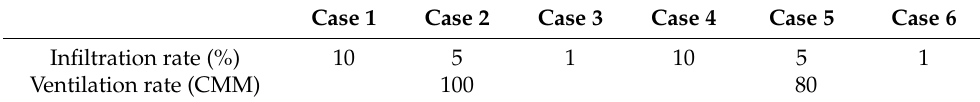
Table 2. The input value of boundary conditions in the numerical model for thermal environment validation.